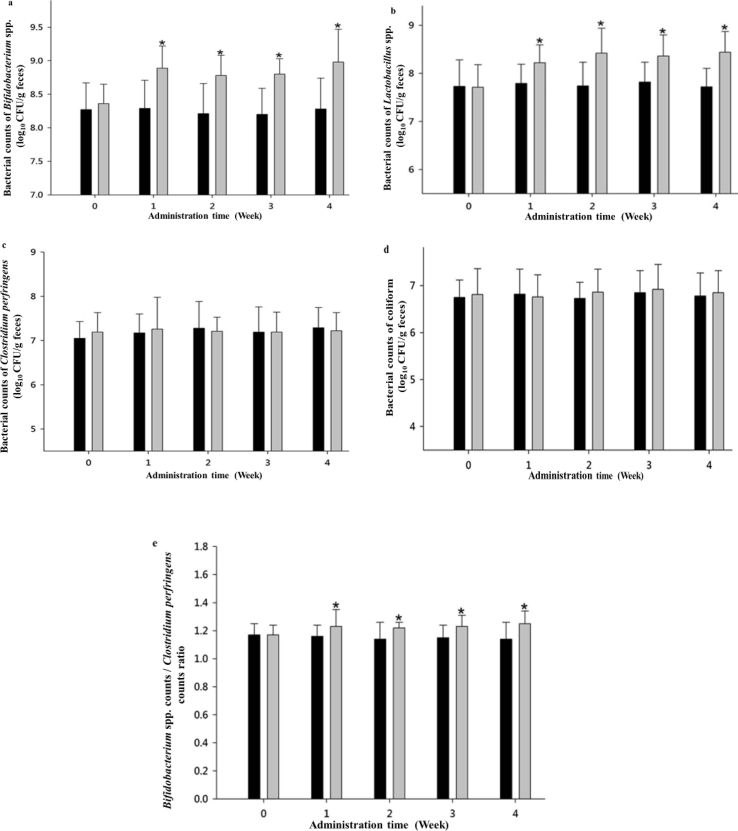
a) Effect of the test product on Bifidobacterium spp. counts in human feces. b) Effect of the test product on Lactobacillus spp. counts in human feces. c) Effect of the test product on Clostridium perfringens counts in human feces. d) Effect of the test product on coliform counts in human feces. e) Effect of the test product on Bifidobacterium spp. counts/Clostridium perfringens counts ratio in human feces. Image 1 Treatment group: Administered a capsule containing 50 mg Vigiis 101-LAB powder; Image 2 Placebo group: Administered a capsule without 50 mg Vigiis 101-LAB powder. All data are expressed as mean ± SD, n = 18. The between-group comparison was carried out with a Student's t-test, wherein P ≤ 0.05 indicates a significant difference between the treatment and placebo groups at the same time point (marked with an ∗).